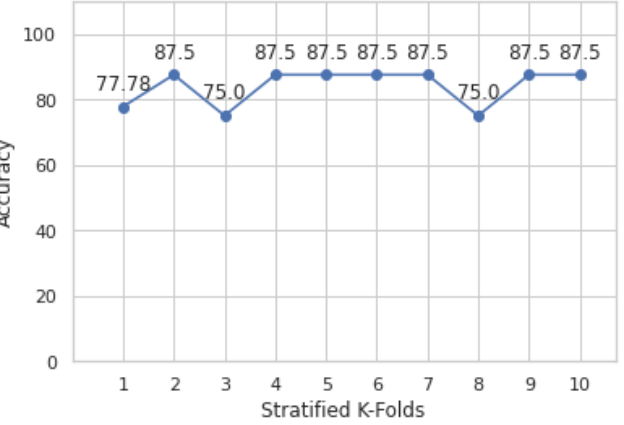
Figure 11. The classification accuracies of the KNN model using the stratified ten-fold cross-valida- tion.